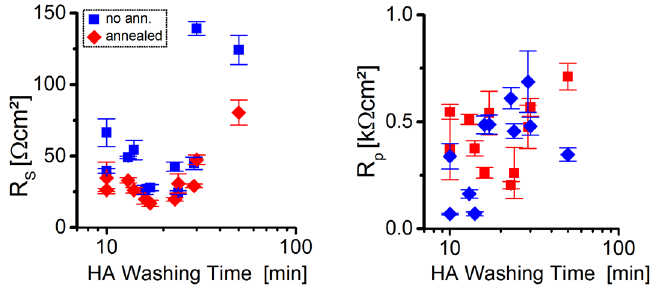
Figure 8. Incorporating differently long HA washed CdSe QDs (100:2:2) into BHJ hybrid solar cells results in different series resistance ( R S ) and parallel resistance ( R P ) values before and after 10 min of thermal annealing.